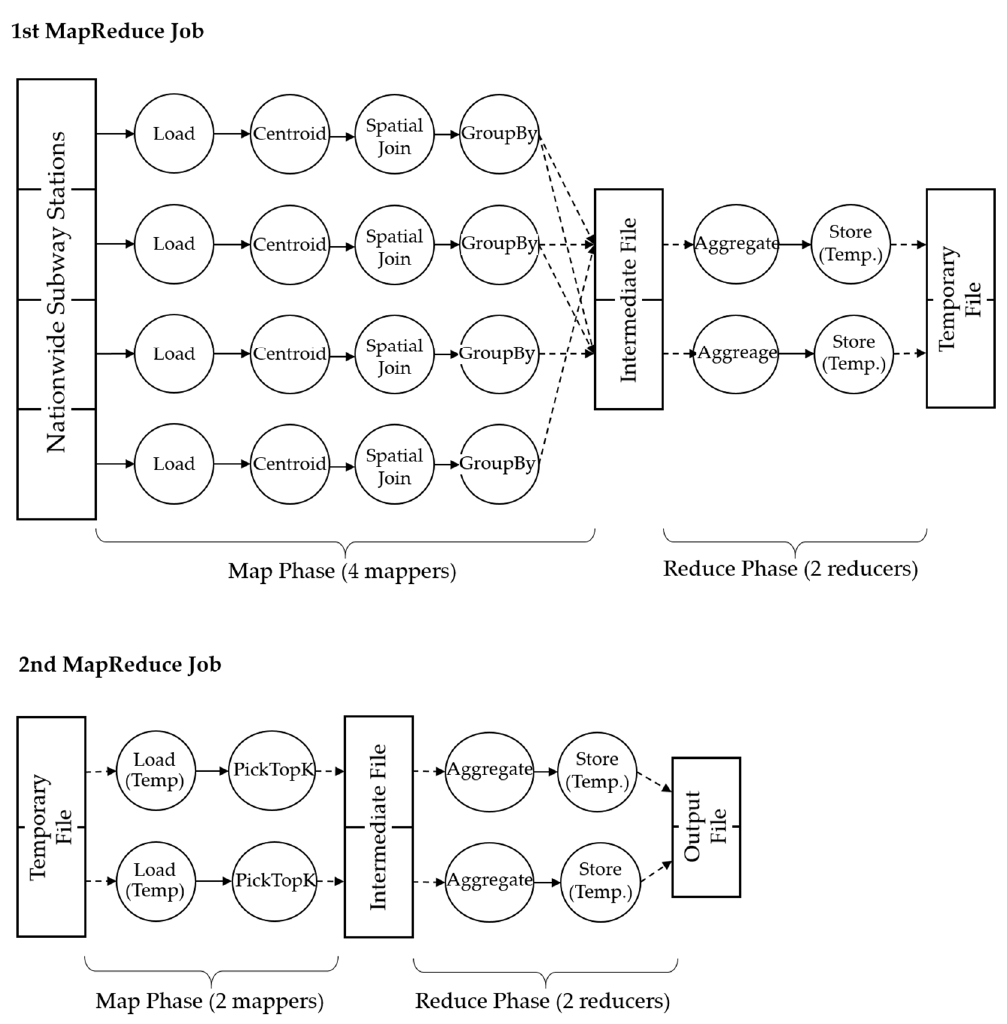
Figure 11. Operations in Map and Reduce phases in the first and second MapReduce jobs.